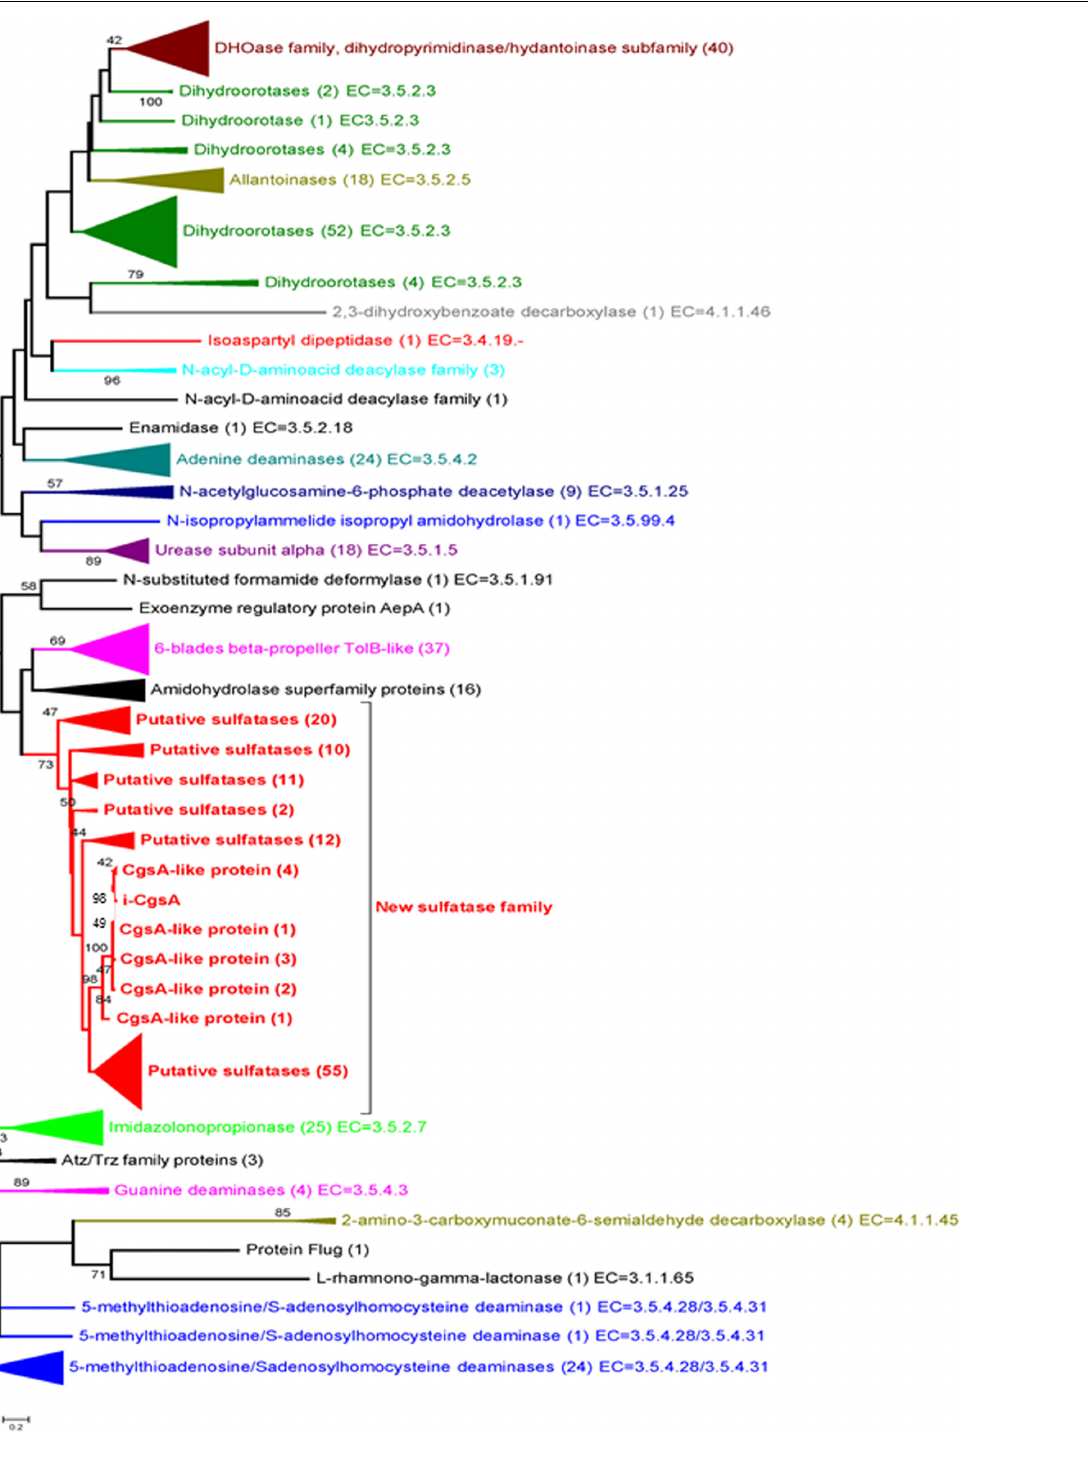
performed using 171 positions, defined from the multiple sequence alignment. All ambiguous positions were removed for each sequence pair. Only the bootstrap values higher than 40 are shown. The potential new sulfatase family (in red) was delimited on the basis of sequence similarities to the here identified sulfatase and the bootstrap value (73) of the best node (the deepest, the first red node) in the tree. Numbers in brackets indicate the number of sequences involved in each